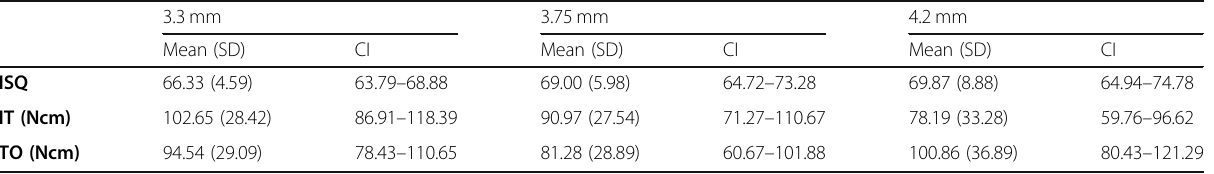
Table 3 Comparison of implant diameter